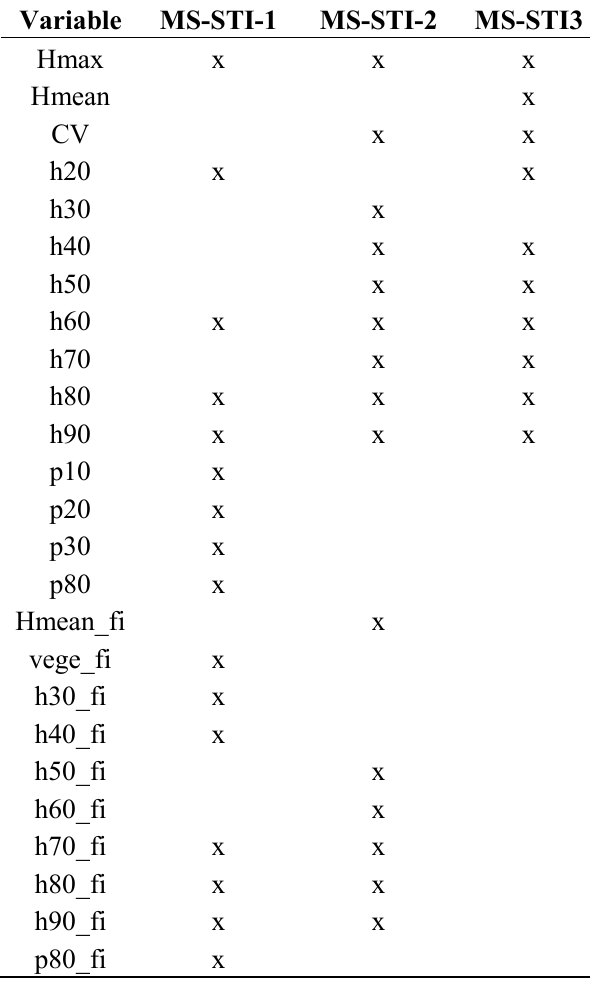
Table 4. Selected predictor